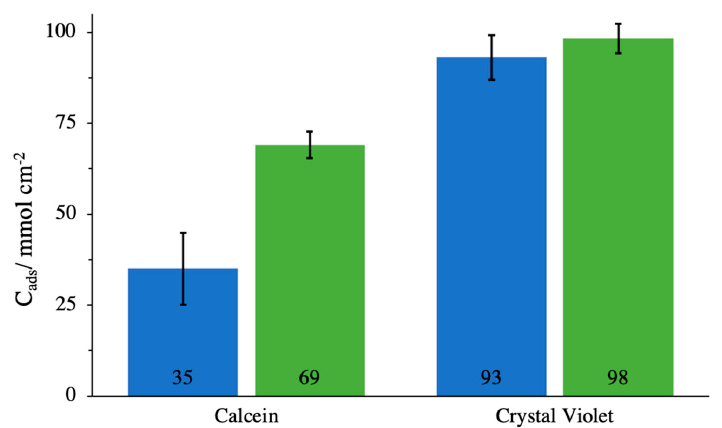
Figure 6. The concentration of respective dye molecules adsorbed after 24 h at the surface of {00.1} (blue) or {104} (green) calcite crystals.